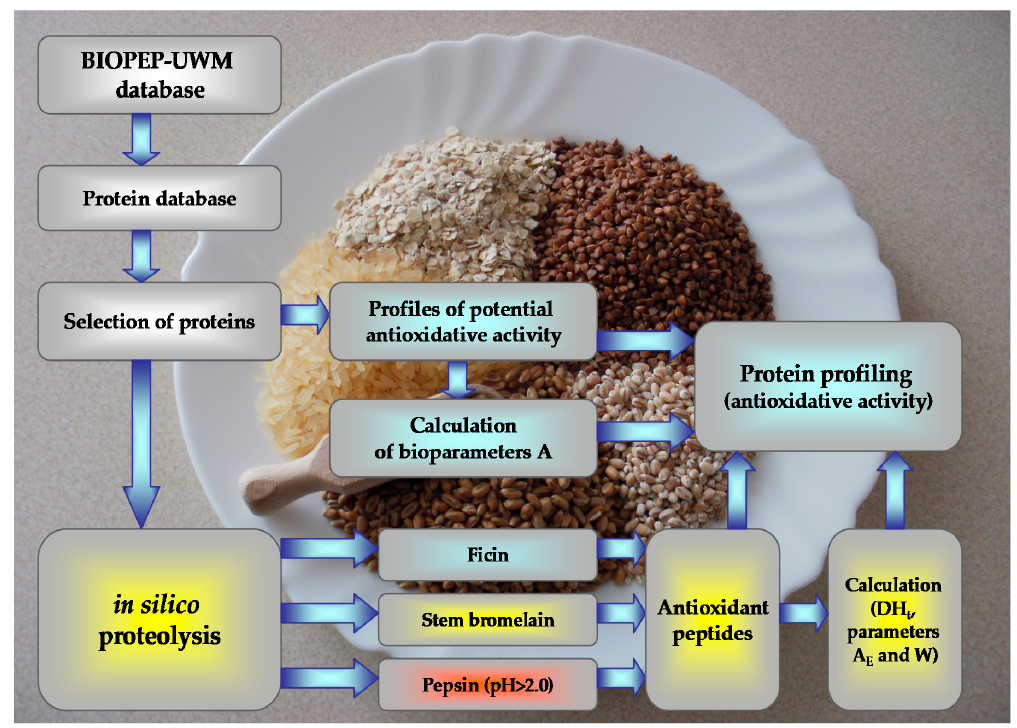
Figure 2. The procedure scheme.